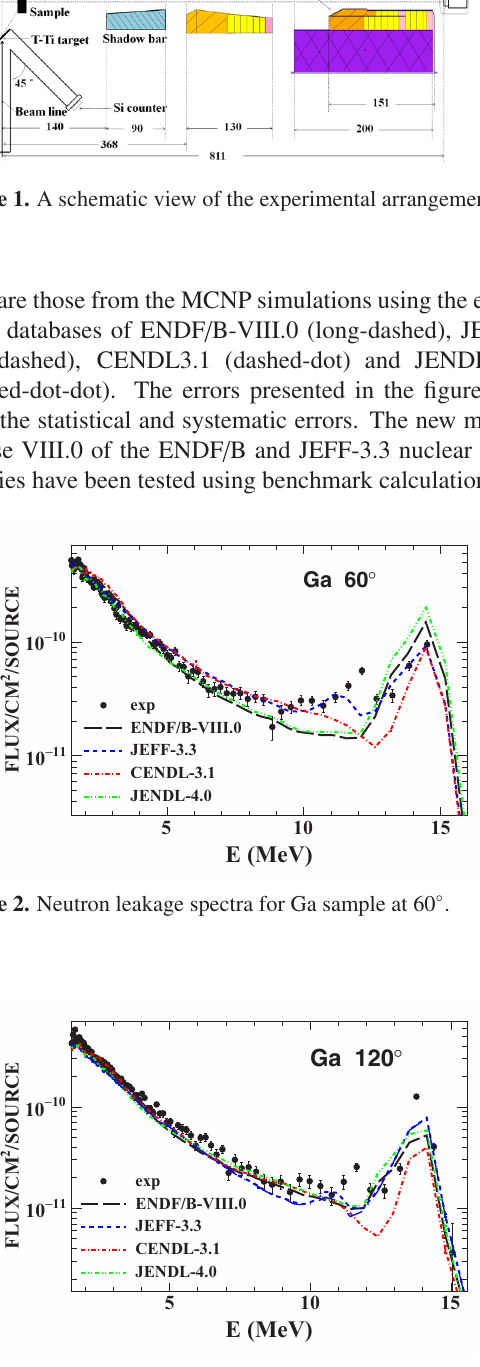
Figure 3. Neutron leakage spectra for Ga sample at 120 ◦ .